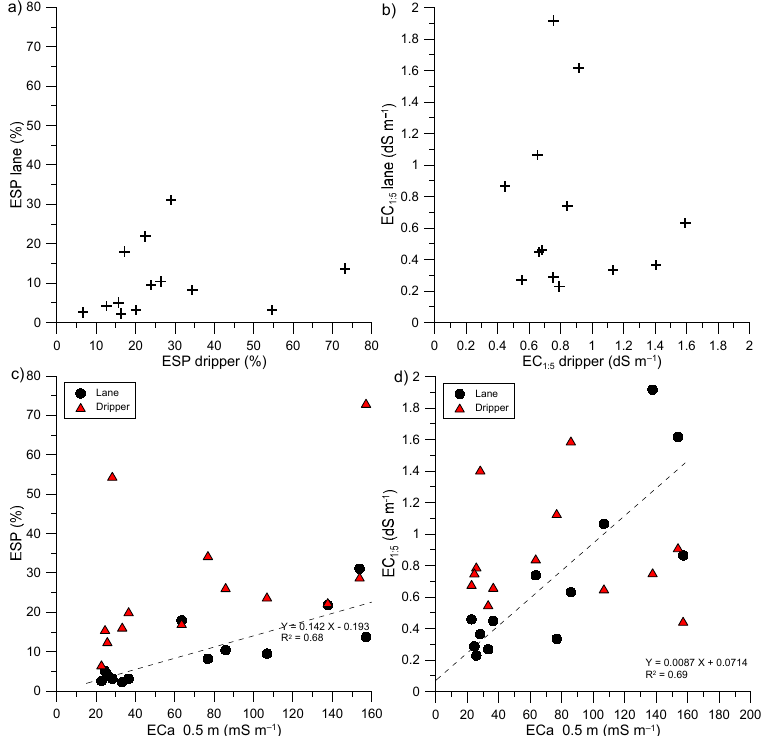
Figure 6. Relationshipsbetween ( a ) ESP and ( b ) EC 1:5 measured (0–0.2 m) under the drippers and in the lanes nearby the profile pits shown in Figure 1. Relationship of ( c ) ESP and ( d ) EC 1:5 , measured in the lanes and under the drippers (0–0.2 m), with the ECa (0–0.5 m) measured in the lanes in 2013. The discontinuous line represents the linear regression for the lane data.